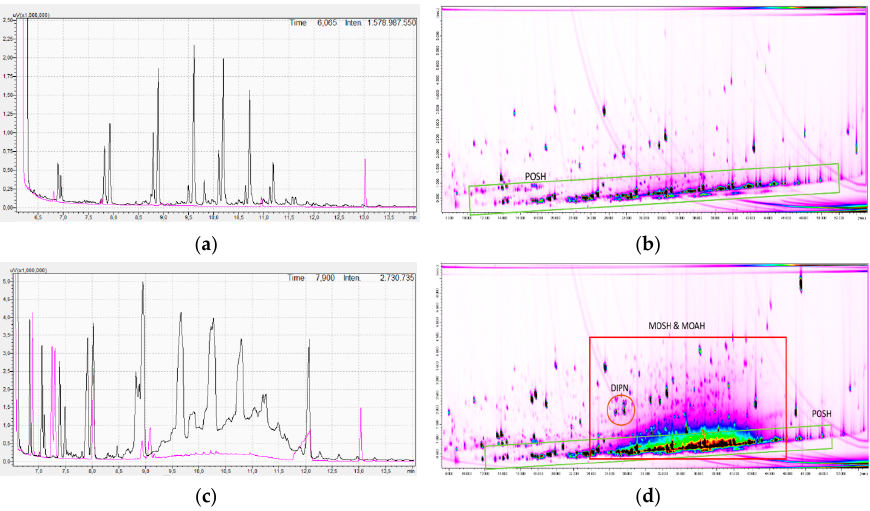
Figure 1. Comparison of high-performance liquid chromatography-gas chromatography with flame ionization detection (HPLC-GC-FID) and comprehensive 2D-GC×GC-MS (GC×GC-MS) chromatograms resulting from migration experiments ( a ) HPLC-GC-FID chromatogram of LLDPE film, ( b ) GC×GC-MS chromatogram of LLDPE film, ( c ) HPLC-GC-FID chromatogram of LLDPE film + donor, and ( d ) GC×GC-MS chromatogram of LLDPE film + donor.